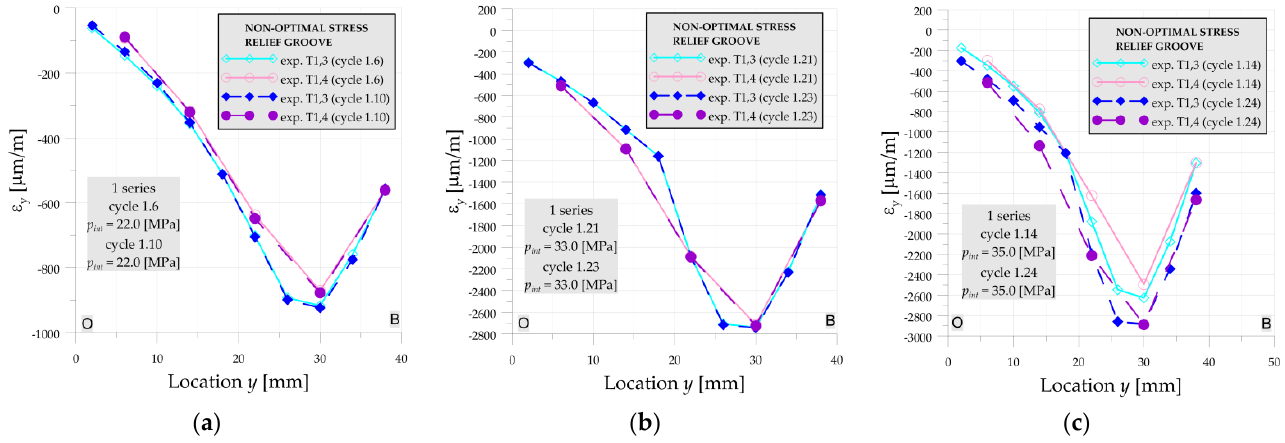
Figure A7. Repeatability of strain gauge measurements, non-optimal SRG, 1st series: ( a ) cycles 6 and 10; ( b ) cycles 21 and 23; ( c ) cycles 14 and 24.